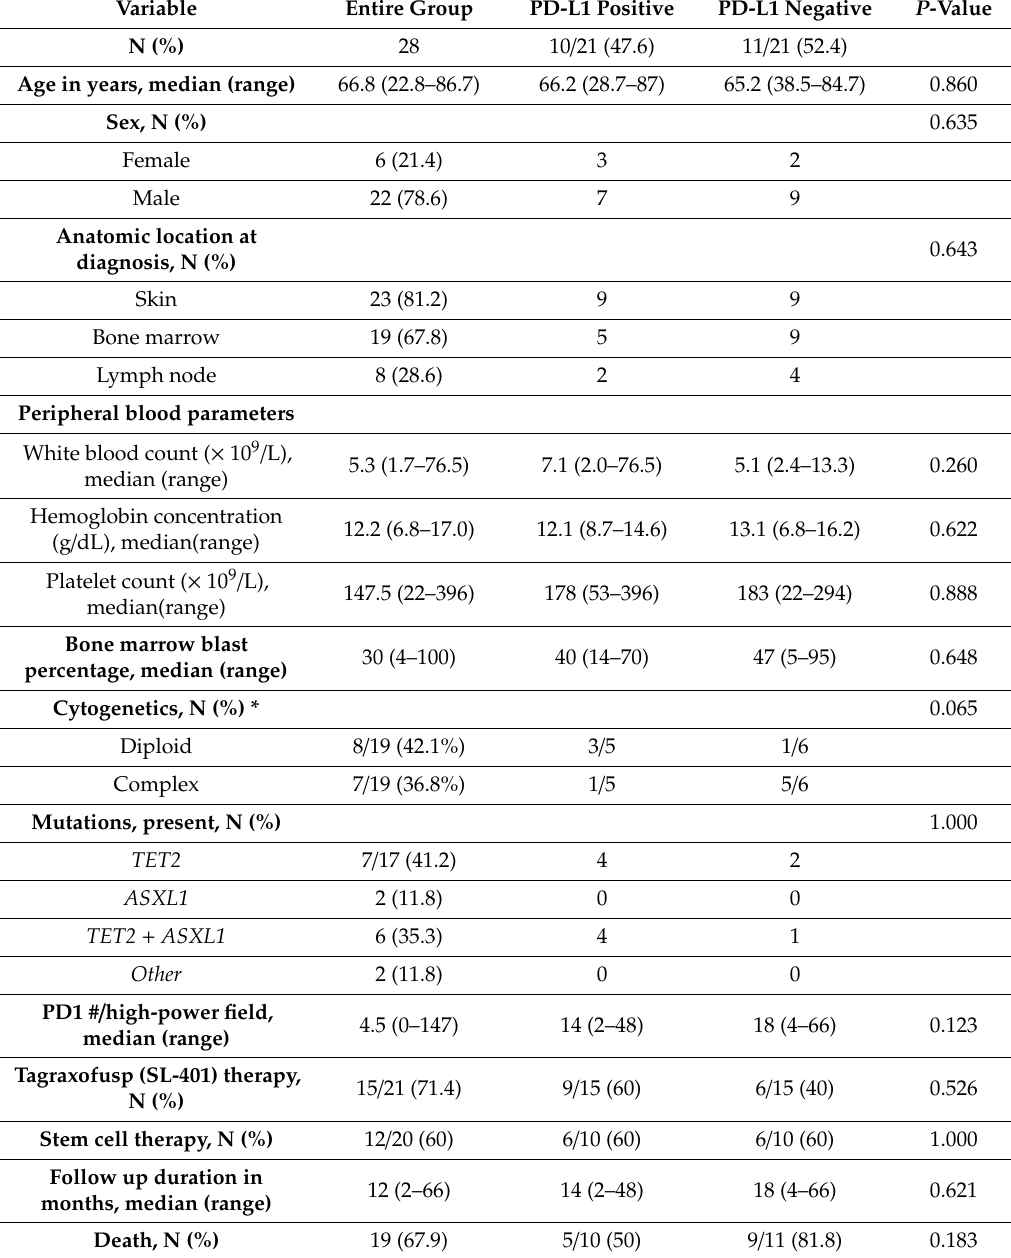
Table 1. Study group